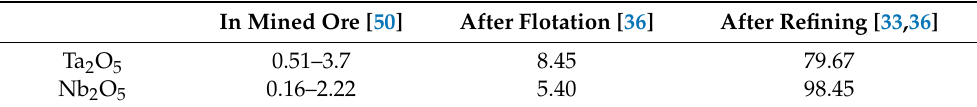
Table 1. Concentration along the beneficiation and refining process (%). In Mined Ore